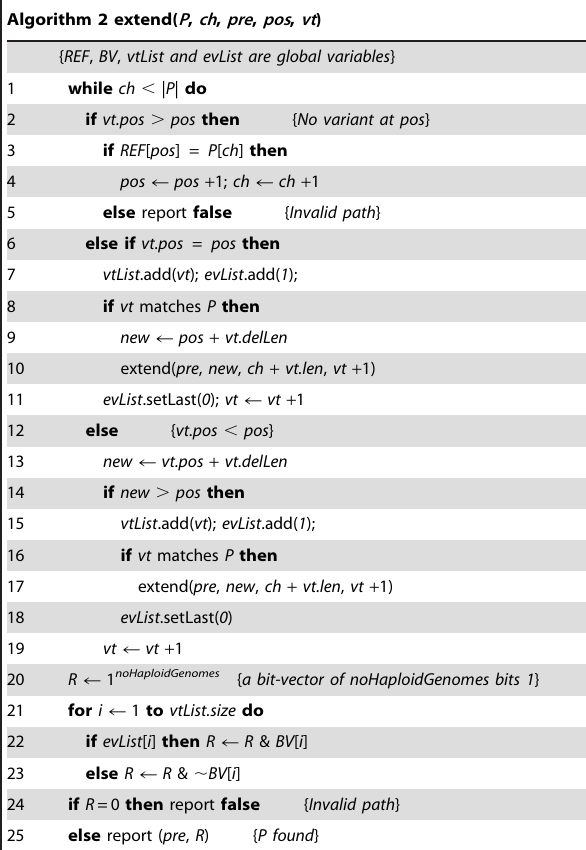
Algorithm 2 extend( P , ch , pre , pos , vt